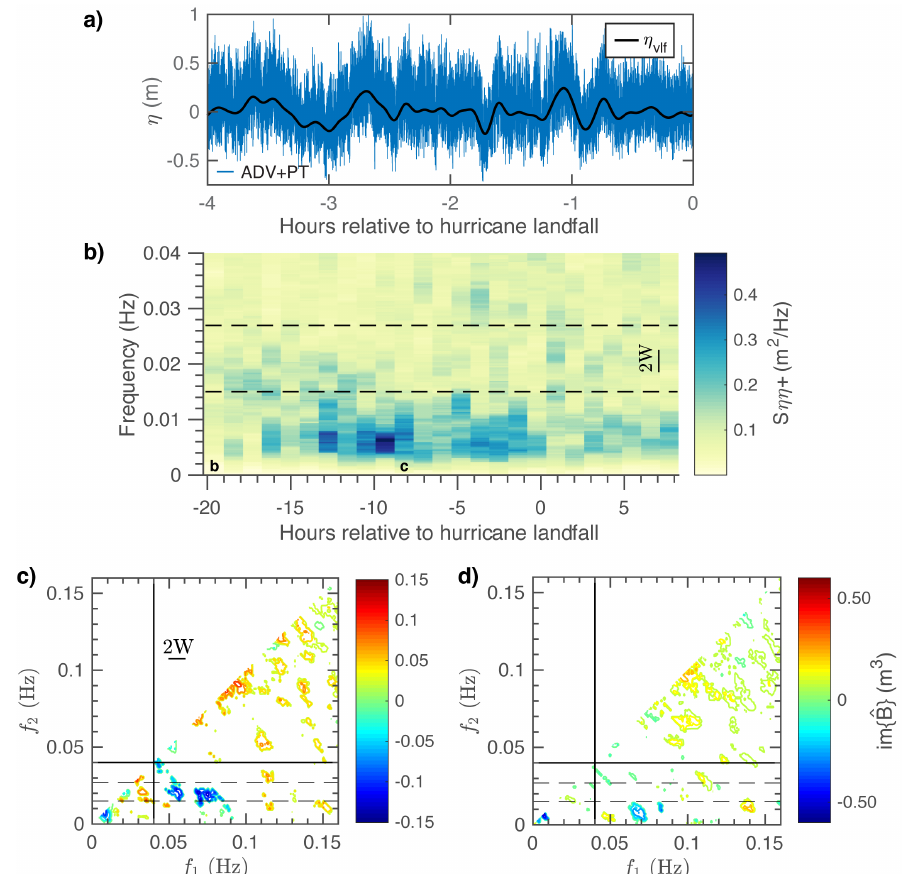
Figure 5. ( a ) time series of the instantaneous free surface elevation η in the surf zone at Follets Island proximate to landfall, low-pass filtered to depict wave phenomena at very-low frequencies (“VLF”, 0.1–3 mHz, 5.6 min to 2.8 h periods); ( b ) surf zone wave power spectra S ηη + (plotted for the IG frequency band only) from Follets Island. Multitaper spectral estimates were generated using ∼ 68 min records of the high-frequency free-surface elevation η + (incoming only, f > 0.002 Hz), a time bandwidth of 8, and 15 Slepian tapers, yielding a passband bandwidth 2 W of 0.0039 Hz and about 28 degrees of freedom (dof) per frequency; ( c ) the imaginary component of the bispectrum im { ˆ B ( f 1 , f 2 ) } early in the storm ( − 19 h) and ( d ) proximate to hurricane landfall ( − 8 h), computed using 8 ∼ 9 min sub-records of η + , a time bandwidth of 3, and 5 Slepian tapers yielding a passband bandwidth 2 W of 0.0117 Hz and about 64 dof per frequency. The solid lines in ( c , d ) correspond to the frequency cutoff between IG and swell energy whereas dashed lines in ( b – d ) partition the IG frequency band into low- (0.003–0.015 Hz), middle- (0.015–0.027 Hz), and high-frequency (0.027–0.04 Hz) components. Bispectral estimates are set to zero below a bicoherence of